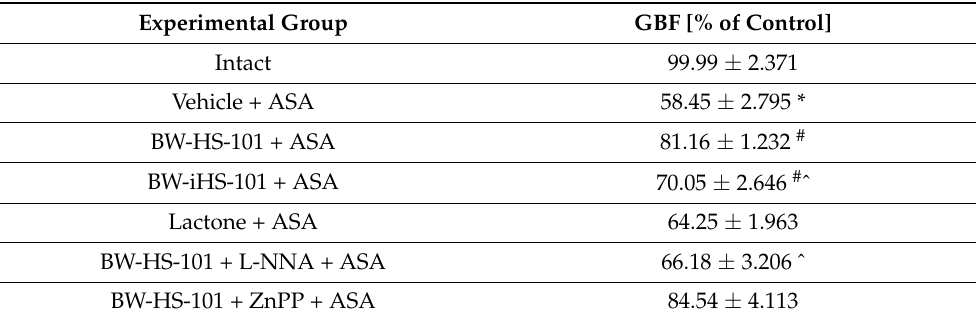
Table 1. Gastric blood flow (GBF) in gastric mucosa of rats pretreated i.g. with vehicle, BW-HS- 101 (50 µ mol/kg), BW-iHS-101 (50 µ mol/kg), lactone (50 µ mol/kg), or BW-HS-101 applied in combination with nitroarginine (L-NNA, 20 mg/kg i.p.) or zinc protoporphyrin IX (ZnPP, 10 mg/kg i.p.), 30 min before i.g. administration of acetylsalicylic acid (ASA, 125 mg/kg). Intact refers